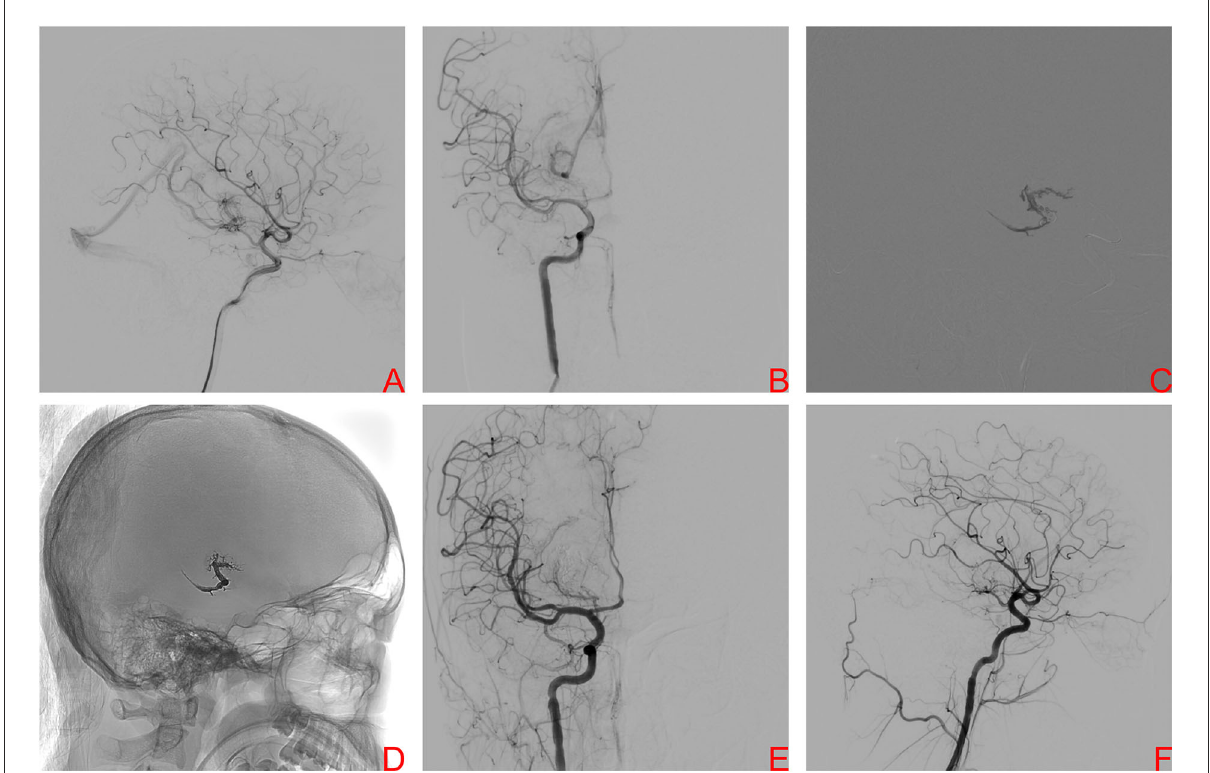
FIGURE3 A right internal carotid artery (ICA) angiogram, anteroposterior projection (A) and lateral projection (B) , demonstrating a Spetzler–Martin grade III brain arteriovenous malformation (BAVM) located in the right basal ganglia drained by the basal vein of Rosenthal, the nidus was supplied by the right AChA and LSAs. After provisional balloon occlusion of theright ICA, Onyx was injected transvenously into the AVM nidus and sufficient retrograde nidal penetration was achieved (C) . The Onyx cast is visualized at the end of the procedure (D) . Final angiography of right ICA, anteroposterior projection (E) and lateral projection (F) , showed complete obliteration of